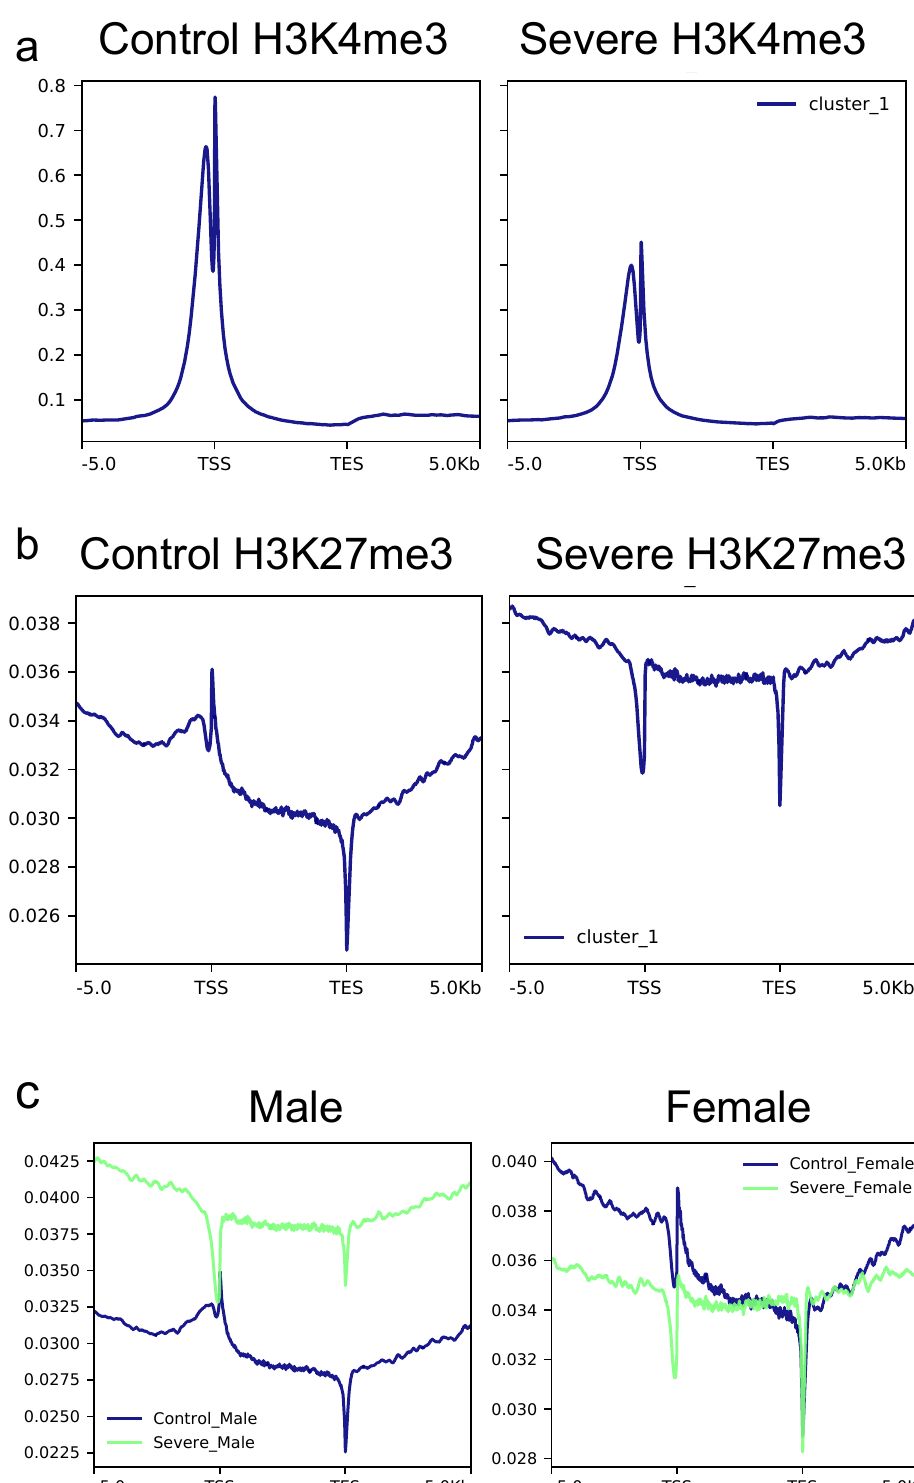
Figure 2. H3K4me3 and H3K27me3 profiles across gene bodies of 77614 transcripts. Samples were merged based on group, and the average normalized profile across the gene body ( ± 5 kb) was calculated. ( a ) The H3K4me3 average profile for the control group shows an overall higher signal than the severe AD group, while an opposite effect is recorded looking at H3K27me3 profiles ( b ). ( c ) H3K27me3 profile was also divided by sex to highlight differences among male (left panel) and female patients (right